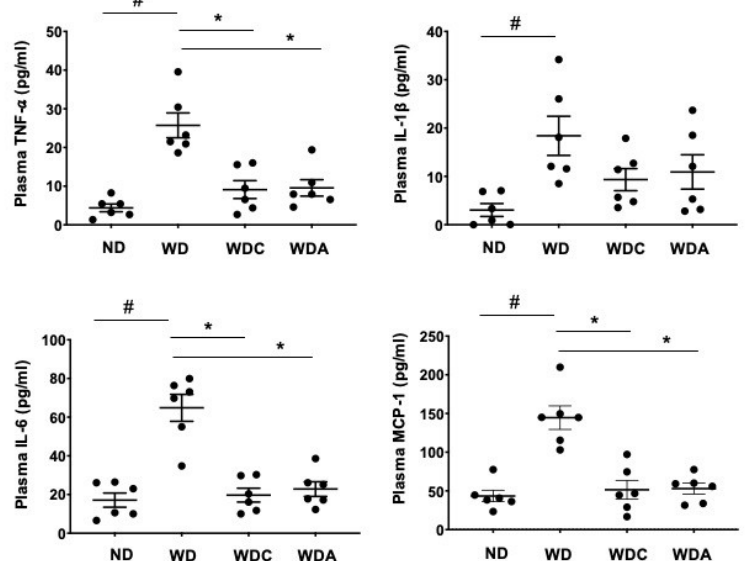
Figure 5. Capsanthin inhibited Western-type diet (WD)-induced proinflammatory cytokines in the plasma of ApoE − / − mice. Each graph shows the plasma levels of tumor necrosis factor- α (TNF- α ), interleukin-1 β (IL-1 β ), interleukin-6 (IL-6), and monocyte chemoattractant protein-1 (MCP-1) in the experimental groups. All values represent the mean ± SEM ( n = 6). # p < 0.05 vs. the ND group; * p < 0.05 vs. the WD group. ND: normal diet, WD: Western-type diet, WDC: capsanthin with Western-type diet, WDA: atorvastatin with Western-type